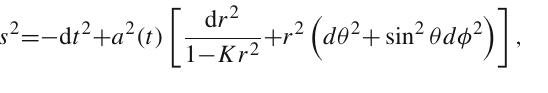
Fig. 1 The scale factor potential U ( a ) for the case of a flat de Sitter Universe (orange-dashed curve), i.e with (cid:2) matter-dominated universe (green-dotted curve), i.e with (cid:2) for (cid:3) CDM paradigm (blue-solid curve), with (cid:2) in units where H 0 =